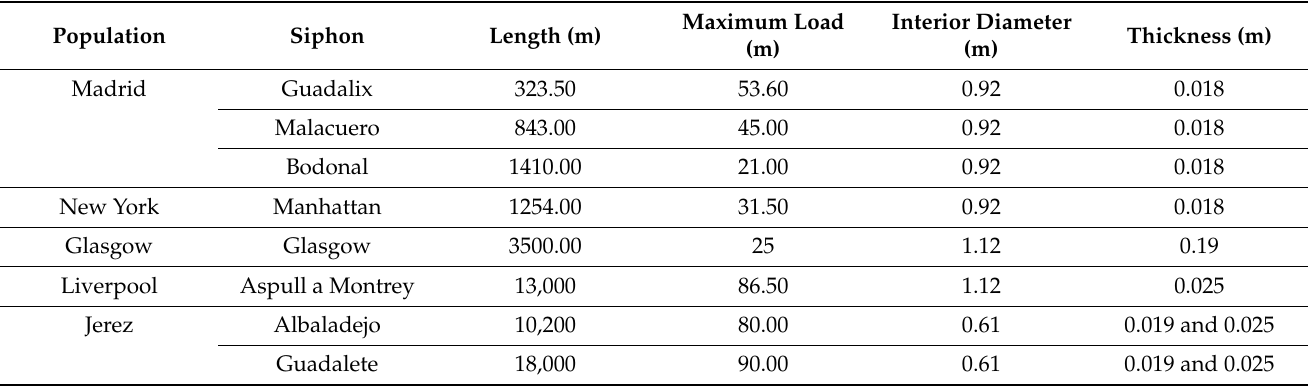
Table 2. Main siphons in Europe. Note the maximum load of those designed in Madrid, exceeded only by the ones in Liverpool